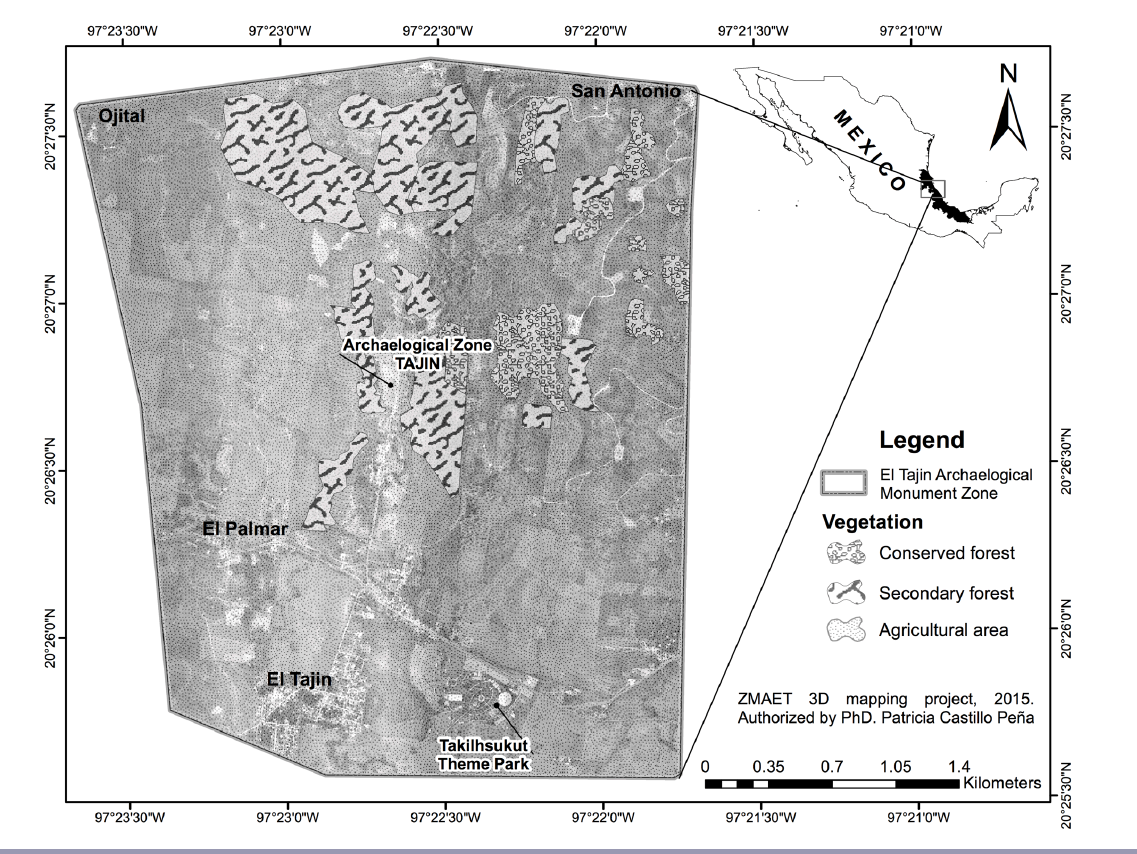
Fig. 2 . Study area: El Tajín Archaeological Monument Zone, Veracruz,